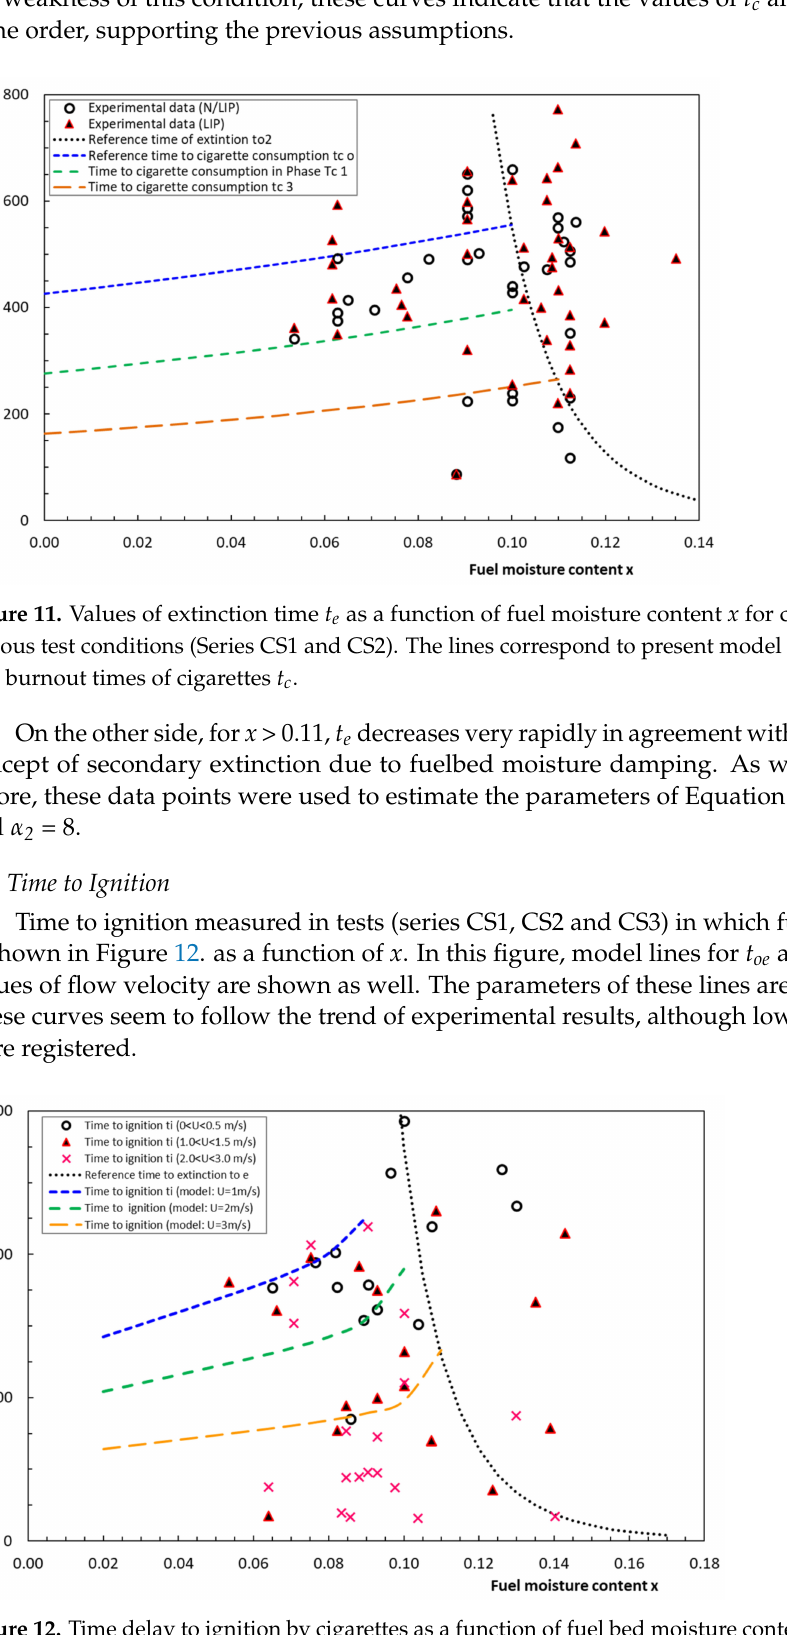
Figure 12. Time delay to ignition by cigarettes as a function of fuel bed moisture content x for various values of flow velocity. The curves correspond to model predictions of t oe (Equation (23)) and t i (Equation (39)), for three values of flow